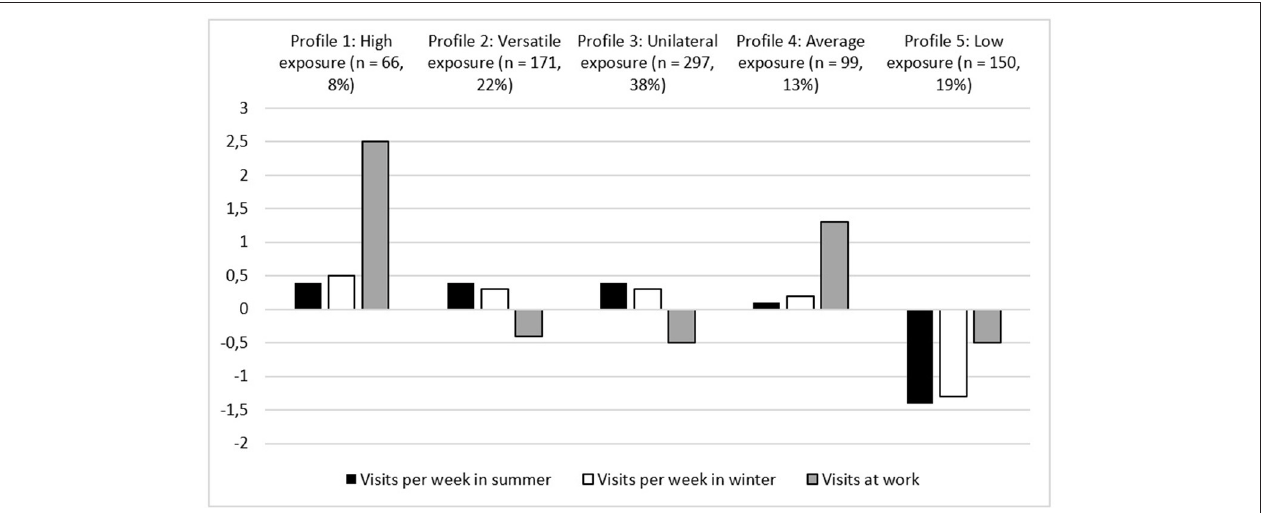
FIGURE 1 | The five-profile solution of the LPA showing the frequency of nature of visits per week in summer and winter during leisure time and the frequency of visits at